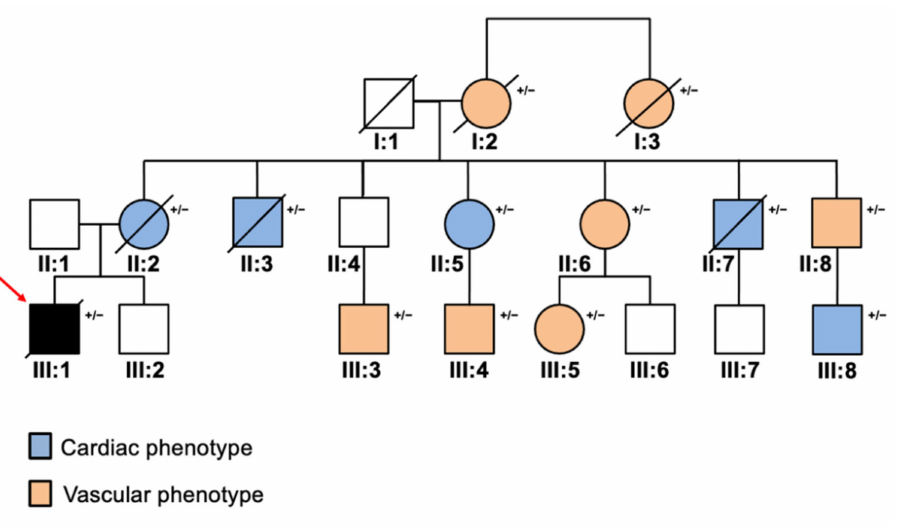
Figure 3. Pedigree of the family with heterozygous familial hypercholesterolemia (HeFH) ( n = 19). Squares indicate males and circles represent females, while slashed symbols mean deceased members. The proband (III:1) is marked by a red arrow. +/ − indicates the presence of LDLR (p.Gly343Cys) mu-